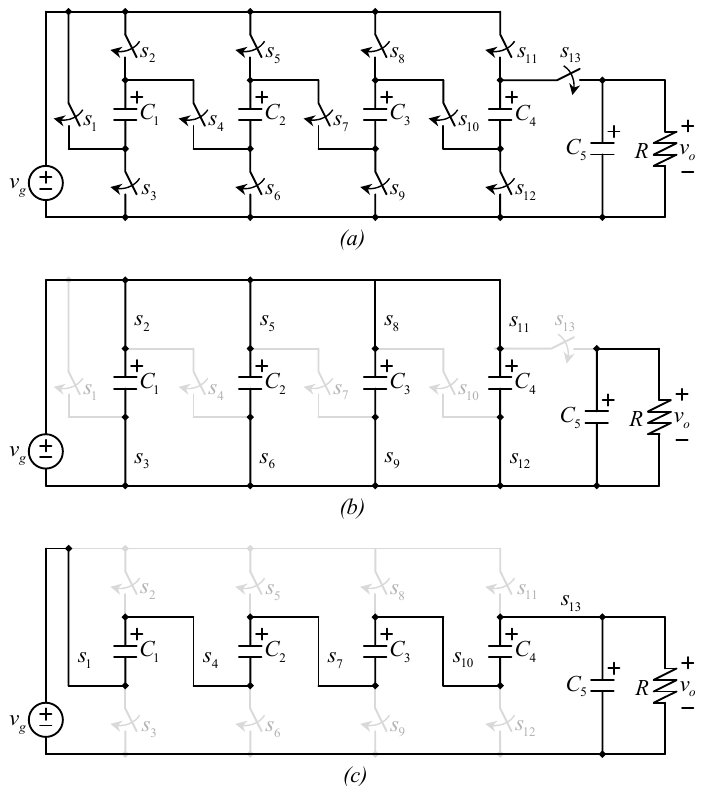
Figure 10. The Series-Parallel Converter and their equivalent switching states, ( a ) topology, ( b ) equiva- lent circuit when capacitors are in parallel, and ( c ) equivalent circuit when capacitors are in series.